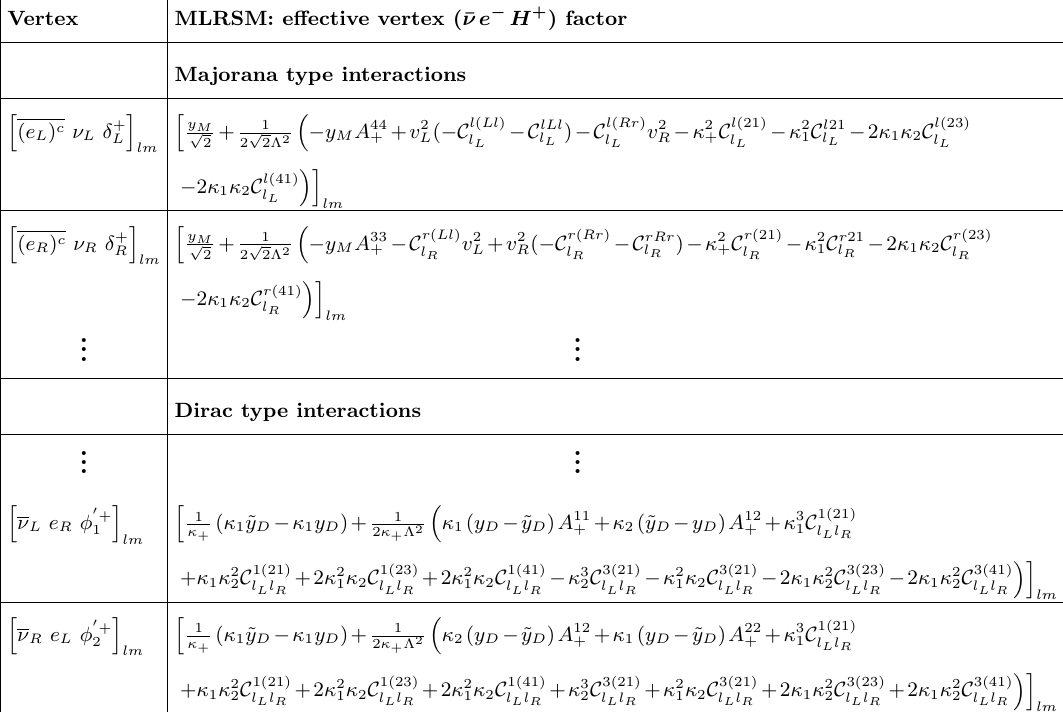
Table 36. MLRSM: couplings of Singly charged scalars with a charged lepton and a neutrino in unphysical basis. A few Majorana type and Dirac type interactions are listed. Here, L; R represent the fermions belonging to SU(2) L ; SU(2) R gauge groups